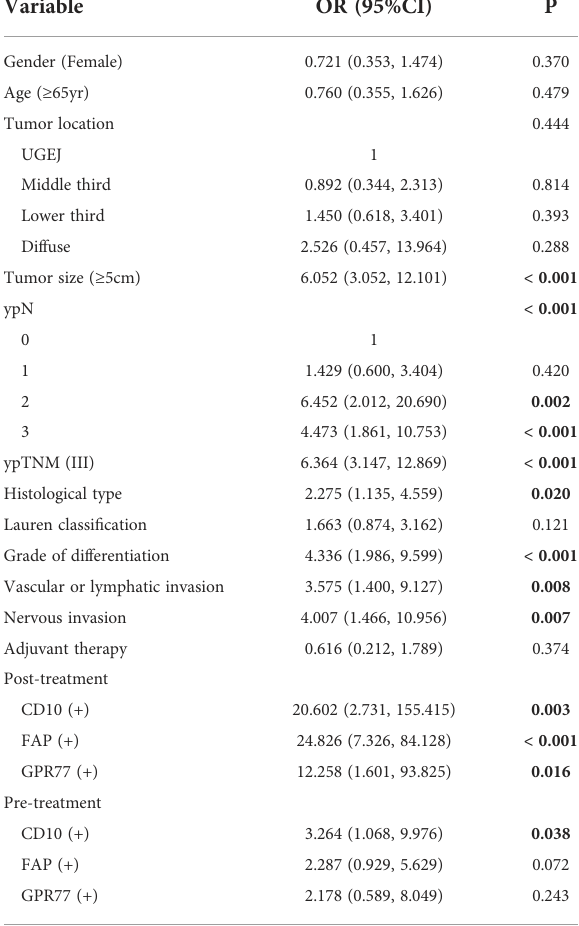
TABLE 2 Univariable analysis for pathological